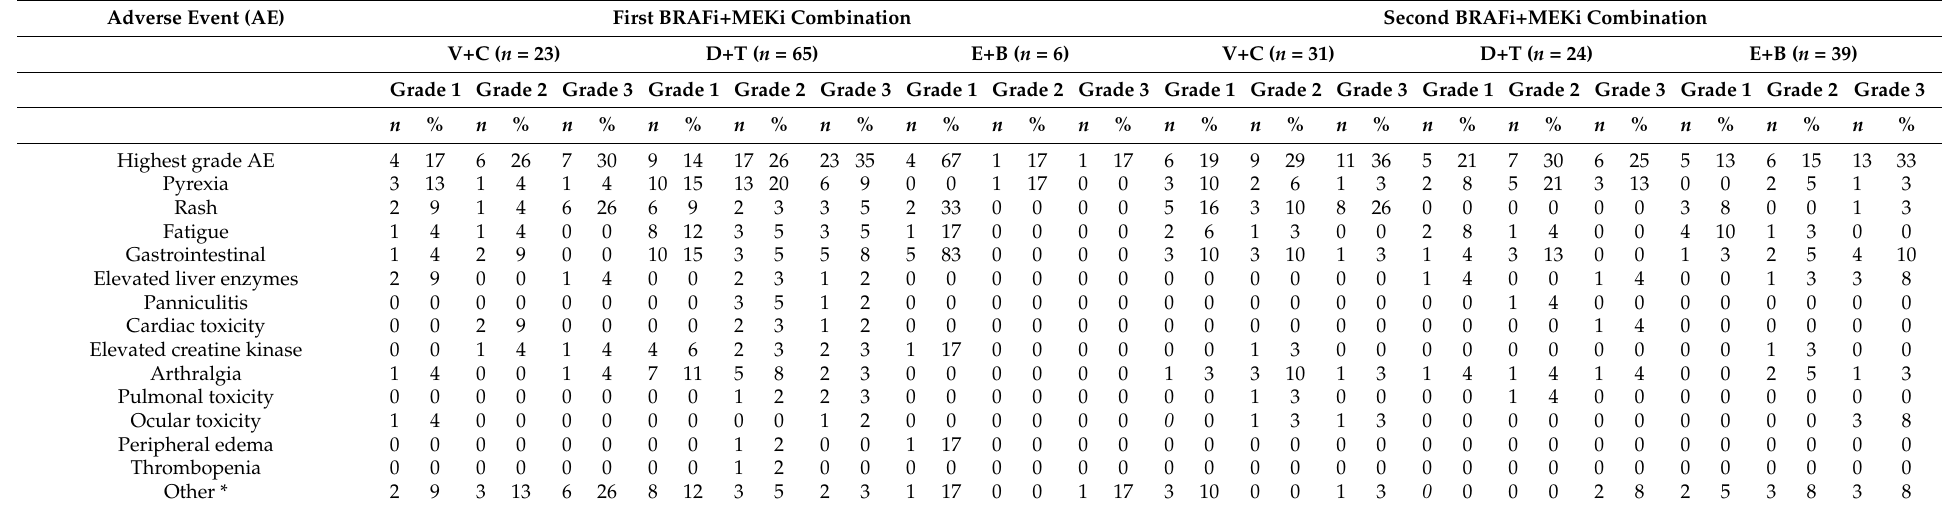
Table 2. All reported adverse events (AE) with their respective grades according to the CTCAE. Several AEs were possible in the same patient. Other * adverse events included: photosensitivity, pericardial effusion, arterial hypertension, loss of appetite, hyponatremia, hypercholesterinemia, acute kidney failure, alopecia, myalgia, sunburn, glomerulonephritis, erythema nodosum, neutropenia with erysipelas, sinusitis, hemophagocytic lymphohistiocytosis, elevated lipase and alcalic phosphatase, pancreatitis, hypophosphatemia, dyspnea, lymphopenia, and